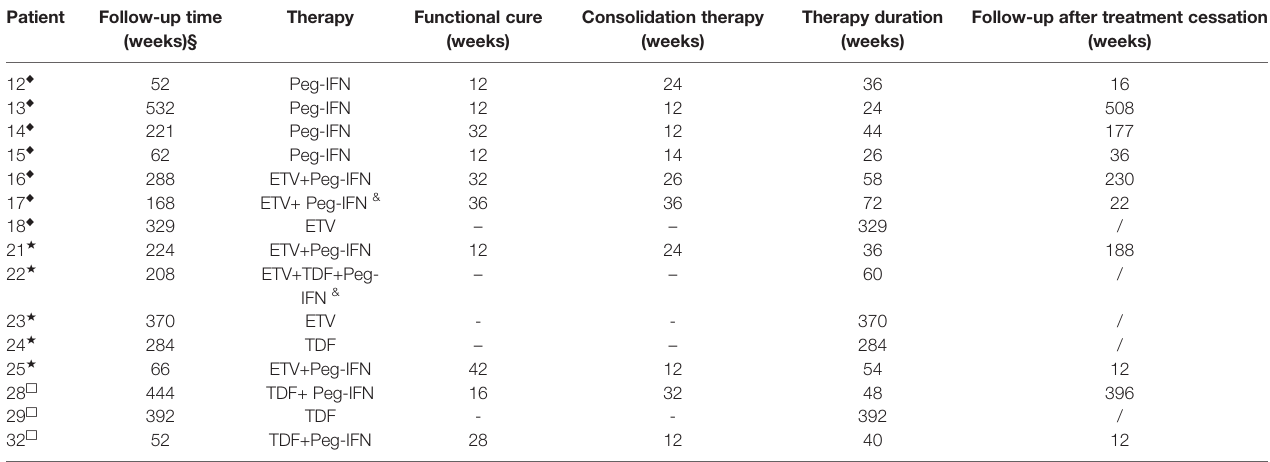
TABLE 2 | Therapeutic method and outcomes of 15 patients who were treated immediately after recurrence.